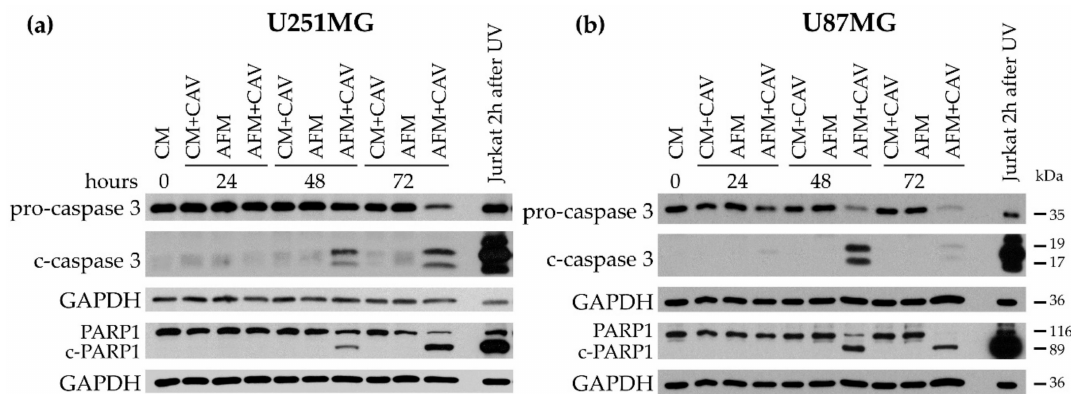
Figure 3. Assessment of the levels of the markers of apoptotic cell death in U251MG ( a ) and U87MG ( b ) cells under 100 µ M canavanine treatment in complete or arginine-free medium. GAPDH was used as a protein loading control. UV-irradiated Jurkat cells were used as a positive